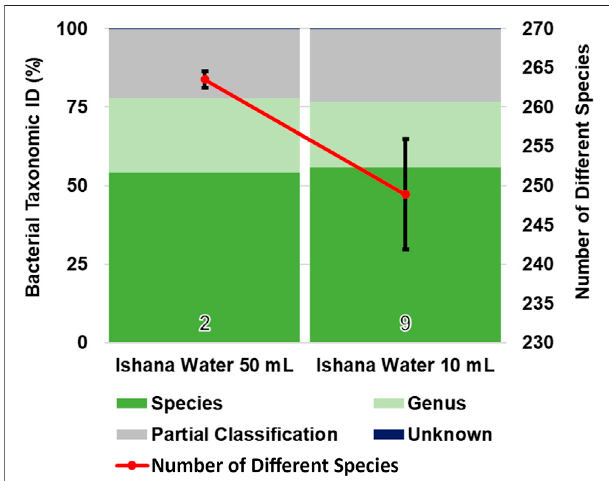
FIGURE4| Comparisonofcollection volumesandbacterialbiodiversity. The taxonomic identi fi cation pro fi le is similar for both collection volumes. Fewer different species (with greater variance between samples) were identi fi ed via 10 ml collection volumes, compared to 50 ml collection